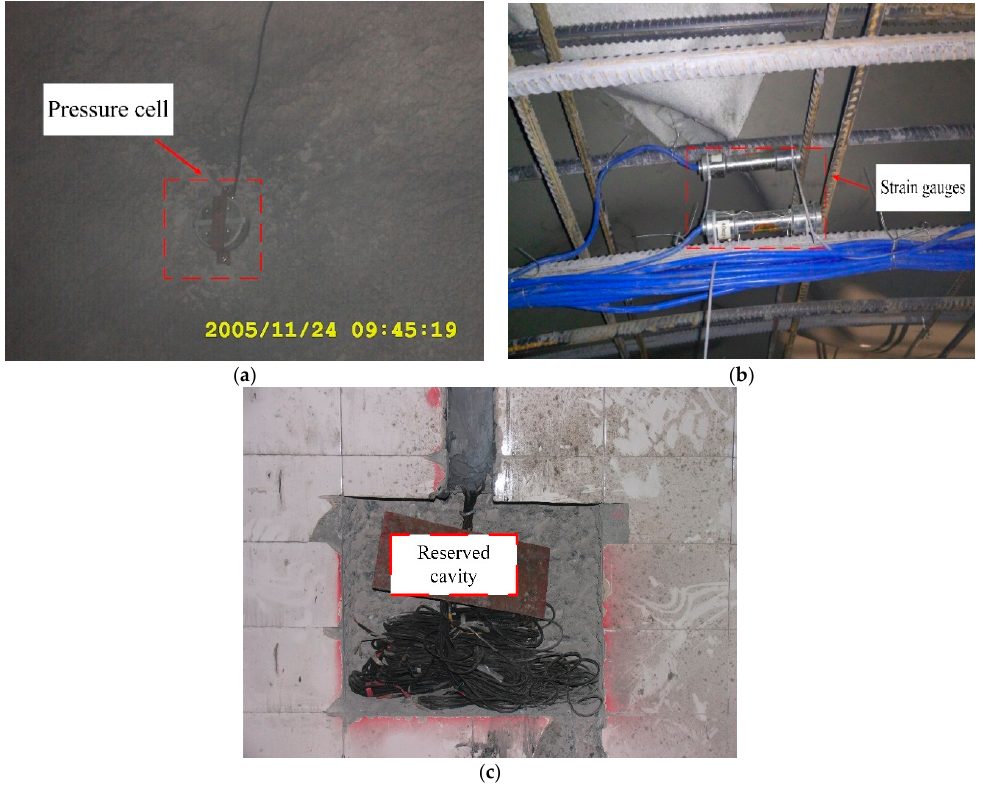
Figure 6. Embedding figures of the reserved cavity, pressure cell, and strain gauge in the field. ( a ) Pressure cell; ( b ) Strain gauge; ( c ) Reserved cavity. ( a ) Pressure cell; ( b ) Strain gauge; ( c ) Reserved cavity.